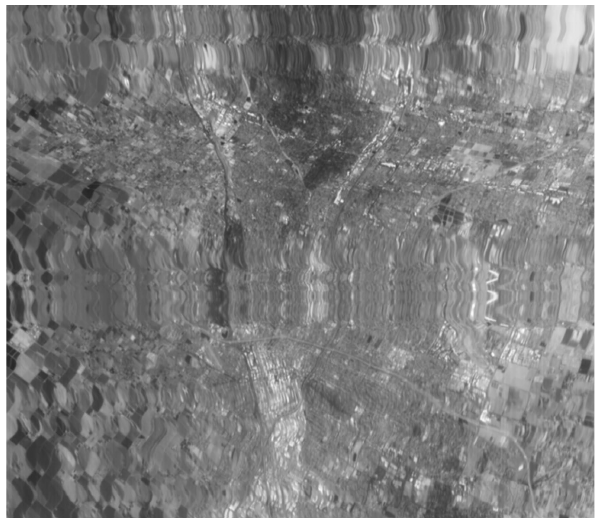
Fig. 4. Among the steps in AirMSPI ground data processing is gen- eration of Level 1B1 calibrated imagery. Rapid aircraft attitude fluc- tuations give rise to distortions from line to line. This 660nm inten- sity image over Fresno, CA, on 6 January 2012 was acquired at a view angle of 67 ◦ and shows these distortions, which are particu- larly evident at the top and center of the image.